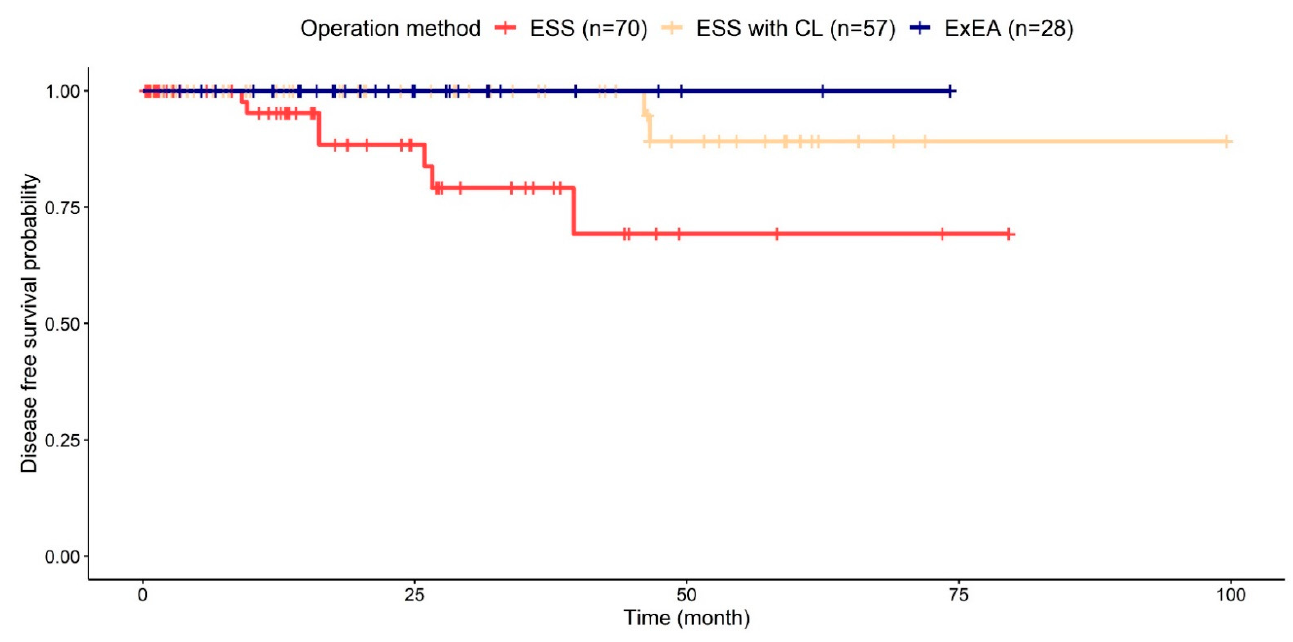
Figure 3. Kaplan–Meier plot according to surgical approach. There were nine recurrences in total: ESS, 10.0% (7/70); ESS with CL, 3.5% (2/57); and EAA, 0% (0/18). There was a significant difference in recurrence rate between the three groups ( p = 0.004, log-rank test). The ExEA group had a lower recurrence rate than the ESS group at 74.2 months after the surgery ( p = 0.024, fixed time-point survival test). ExEA—expanded endoscopic approach; ESS—endoscopic resection via middle meatal antrostomy and/or inferior meatal antrostomy; ESS with CL—ESS with the Caldwell–Luc approach or canine fossa trephination. The recurrence rates in primary and revision cases were 6.0% (7/117) and 5.3% (2/38), respectively. The Kaplan–Meier plot revealed no significant difference in recurrence rates between primary and revision cases (Figure 4). In a subgroup analysis excluding revision cases (n = 117), the recurrence rate in the ExEA group was significantly lower than that in the ESS group ( p = 0.010; Figure 5), which was consistent with the analysis of all patients.